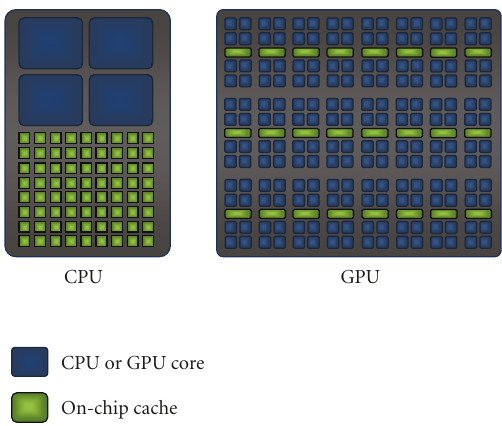
Figure 1: An illustration of the di ff erences between CPUs and GPUs.